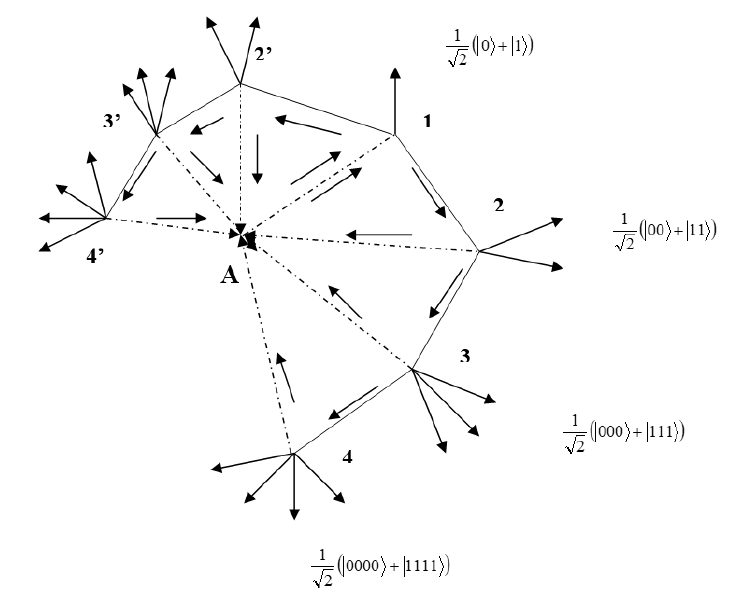
Figure 9. The interaction